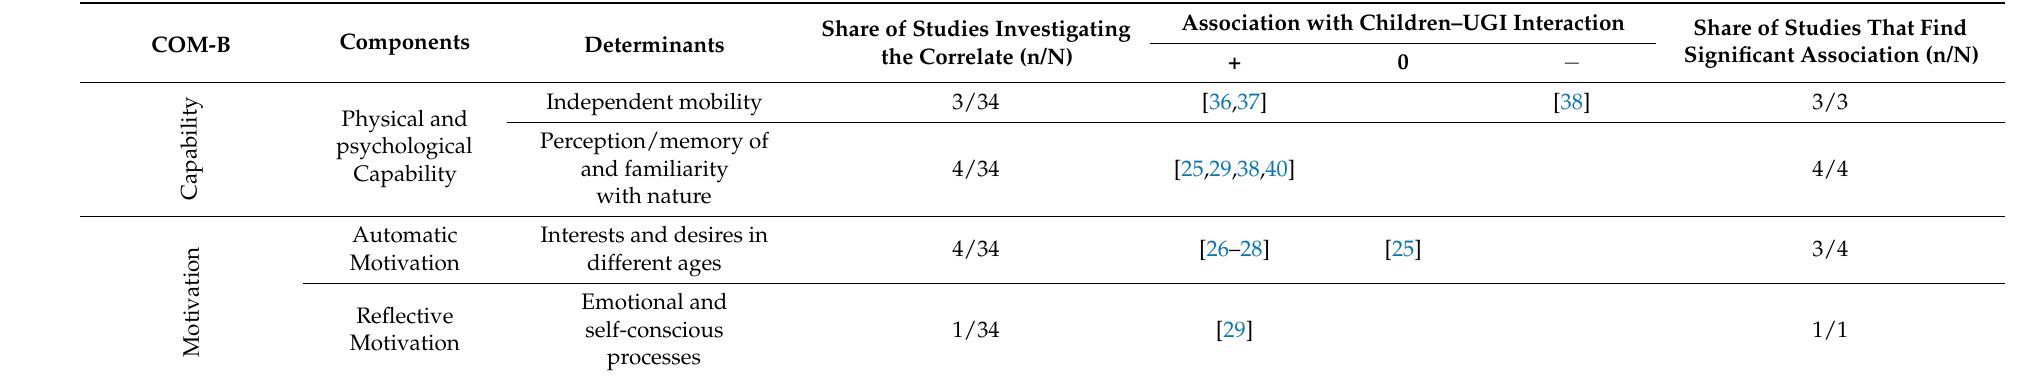
Table A2. The identified correlates and their association with children–UGI